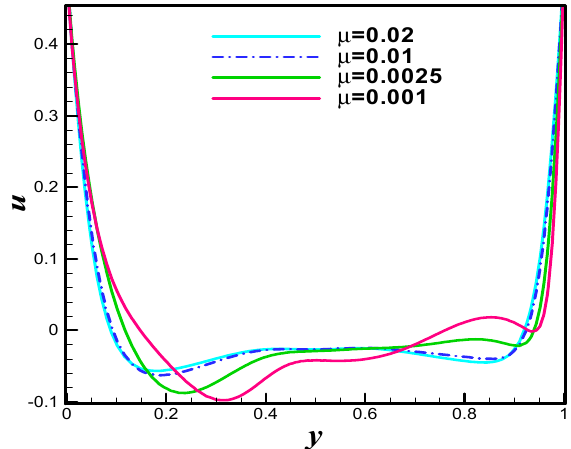
Figure 29. The u - velocity profile for case-II.